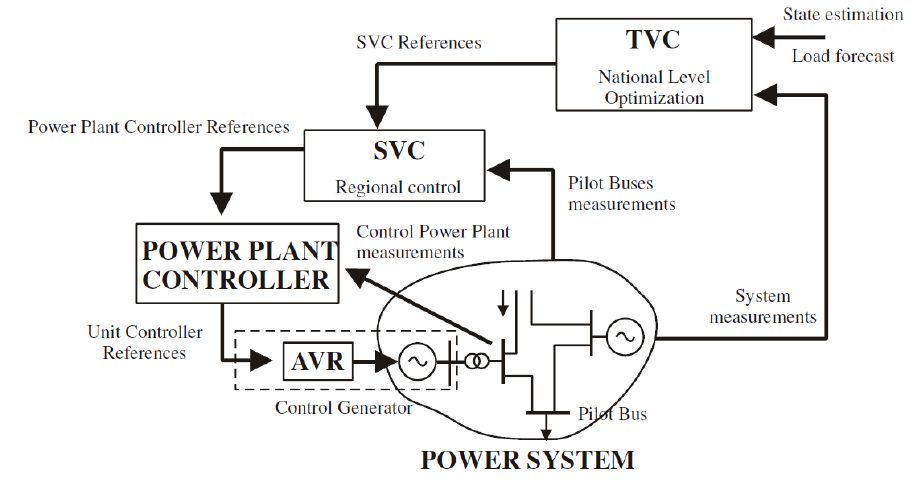
Figure 6. Hierarchical architecture of the Italian automatic voltage regulation system [22].